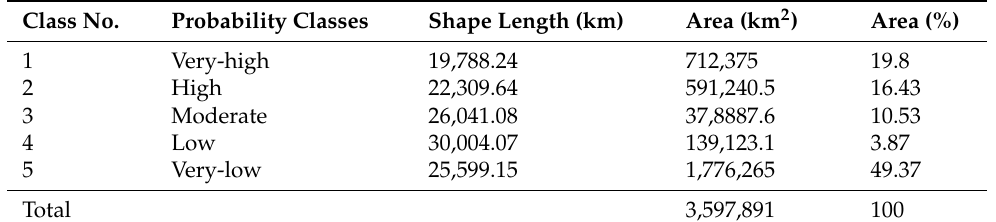
Figure 8. Classified earthquake probability map of India. Table 5. Earthquake probable areas in km 2 and